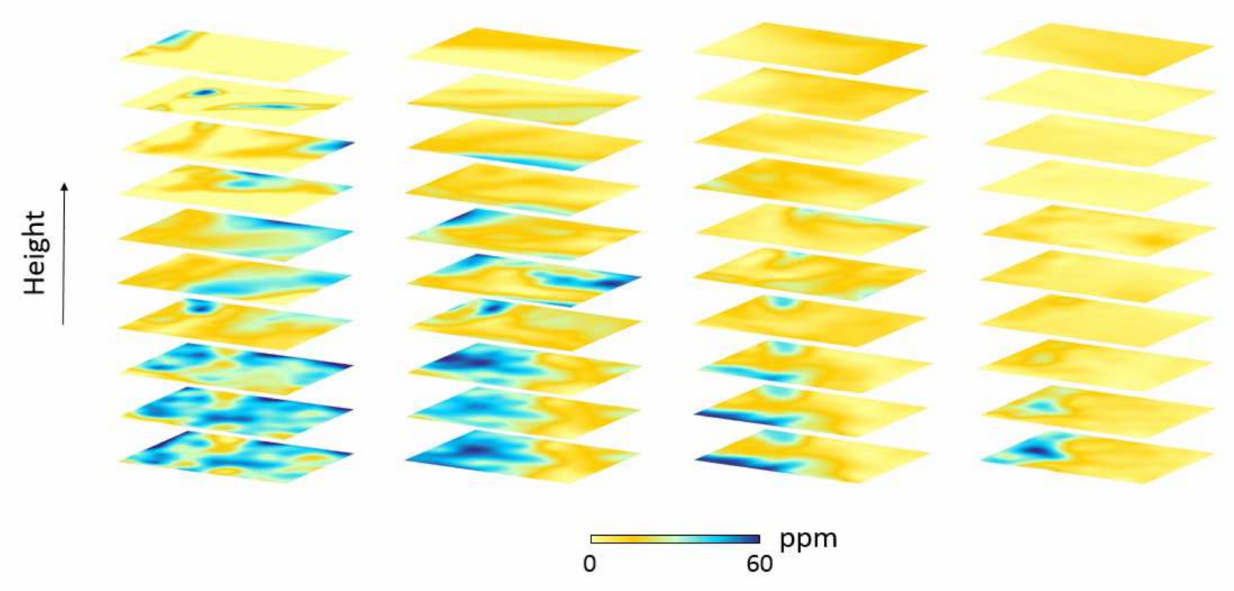
Figure 7. Samples of reconstructed wet refractivity field at epochs 14,124, 14,484, 14,844, and 15,204, from left to right.